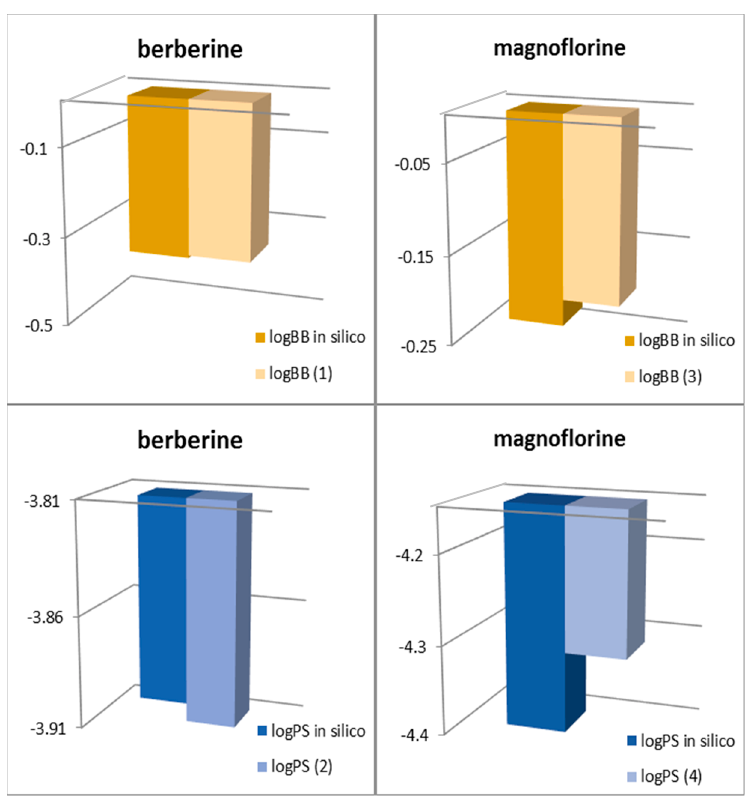
Figure 1. Comparison between the logBB (logPS) calculated in silico and the values obtained from the newly constructed models.